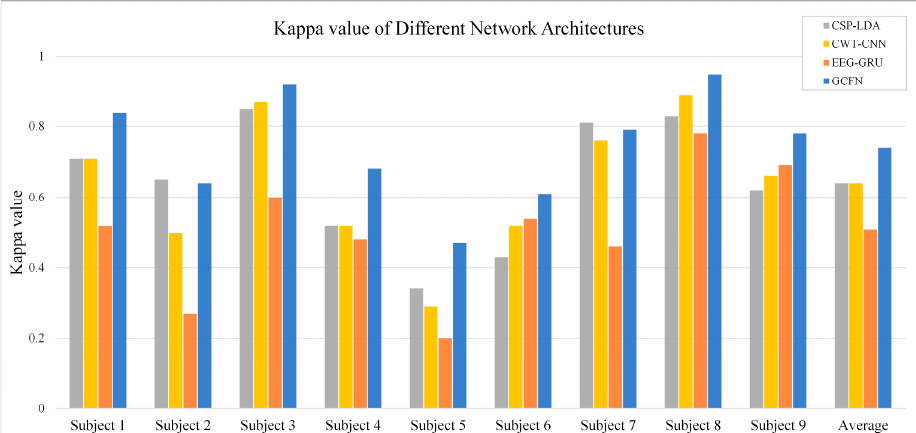
Figure 12. The average Kappa value of each subject under different models.